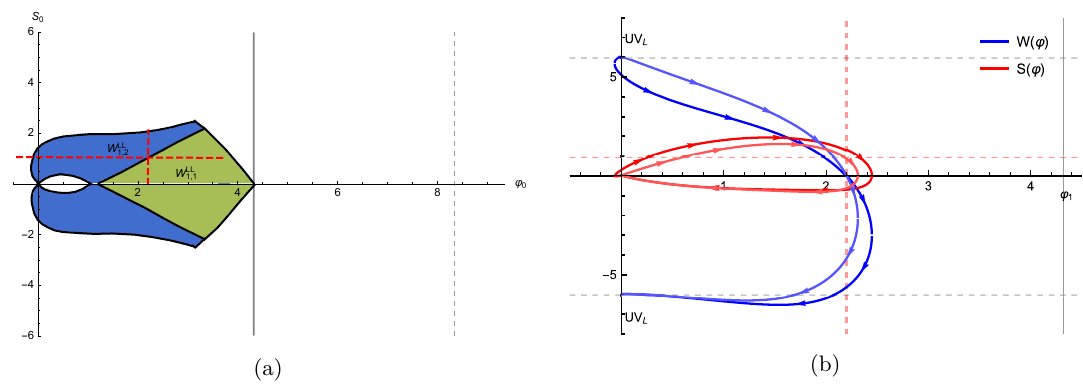
and type W LL 1 , 2 1 , 1 region and the flow 1 , 2